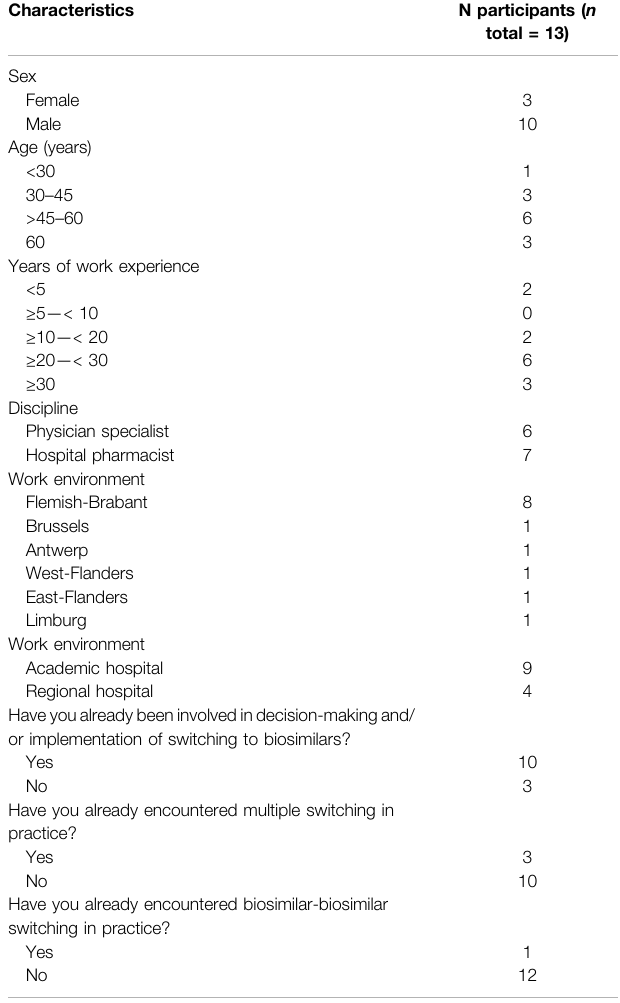
TABLE 1 | Participant